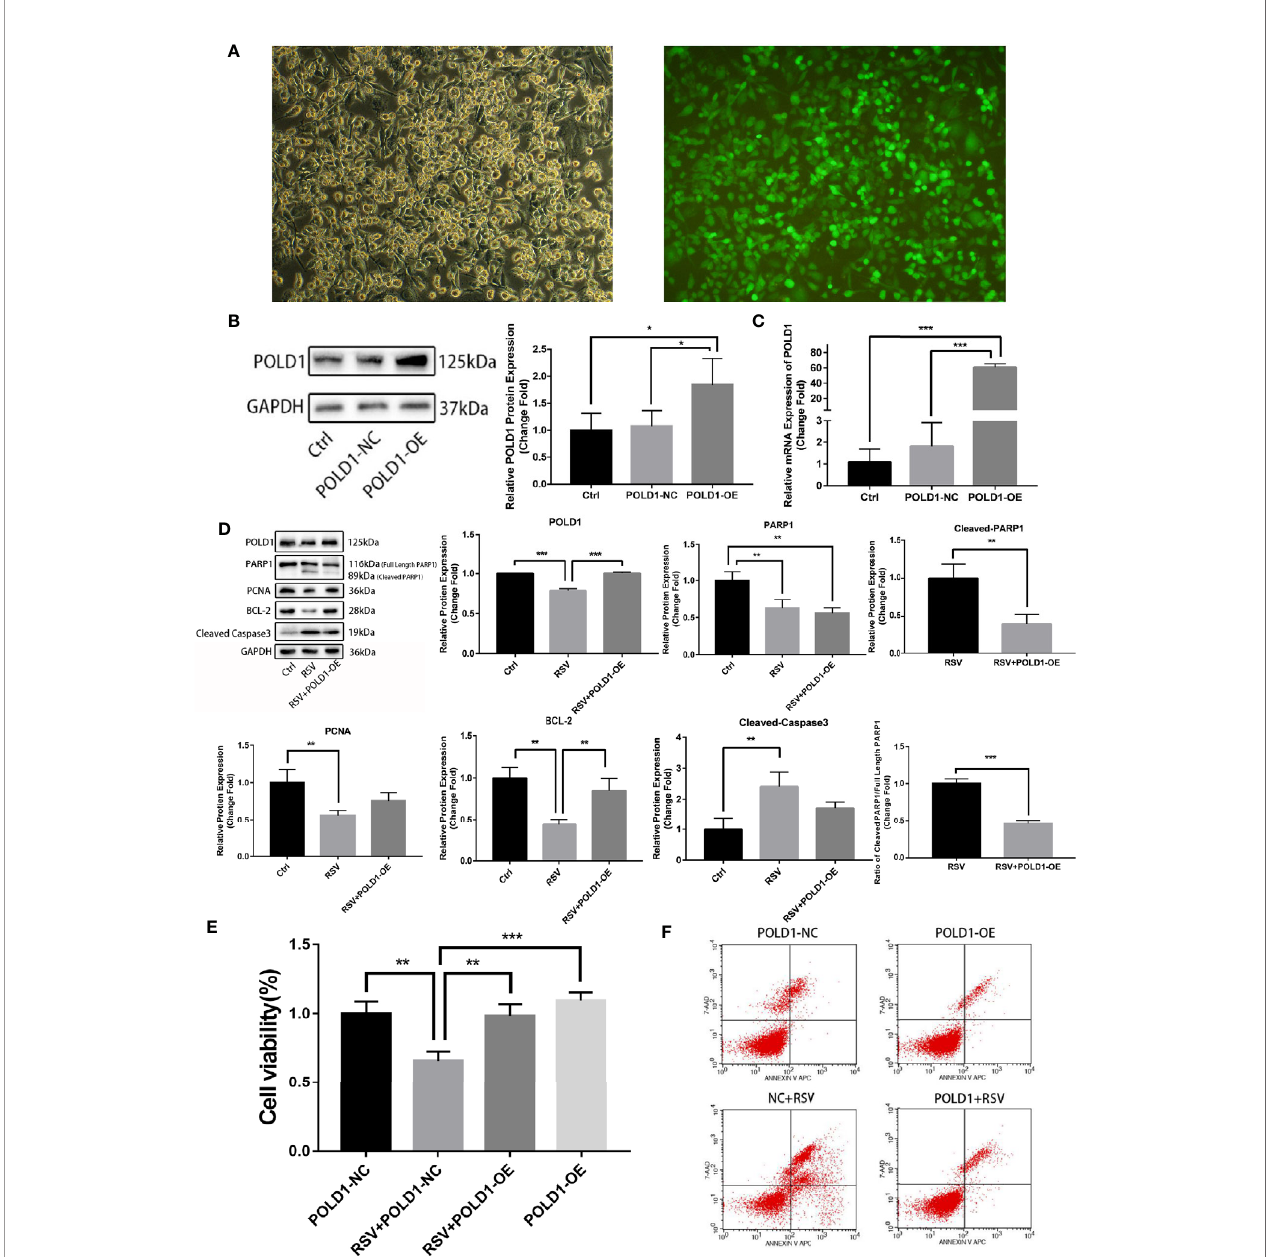
FIGURE 6 | POLD1 rescue experiment (A) Immuno fl uorescence of POLD1 transfected with lentivirus. (B) POLD1 protein expression after transfection (control and POLD1-NC: * P =0.035, POLD1-NC and POLD1-OE: * P =0.048). (C) Gene expression of POLD1 after transfection (control and POLD1-NC: ** P =0.007, POLD1-NC and POLD1-OE: ** P =0.007). (D) Apoptosis indicators of breast cancer cells after transfection (POLD1:*** P <0.001, PARP1: control and RSV+POLD1-OE: ** P =0.004, RSV and RSV+POLD1-OE: ** P =0.001, Cleaved PARP1/Full Length PARP1: *** P <0.001, PCNA: ** P =0.004, BCL-2:control and RSV: ** P =0.001, RSV and RSV +POLD1-OE: ** P =0.006, Cleaved Caspased 3: ** P =0.003),. (E) CCK8 detection of resveratrol treated breast cancer cell survival after transfection (** P =0.001, *** P <0.001). (F) Flow cytometry detection of resveratrol-treated apoptosis of breast cancer cells after transfection (on the two-parameter scatter diagram of fl ow cytometry, the lower left quadrant represents living cells; the upper left quadrant represents necrotic cells; the lower right quadrant represents apoptotic cells (late apoptotic cells), and the upper right quadrant represents early apoptotic